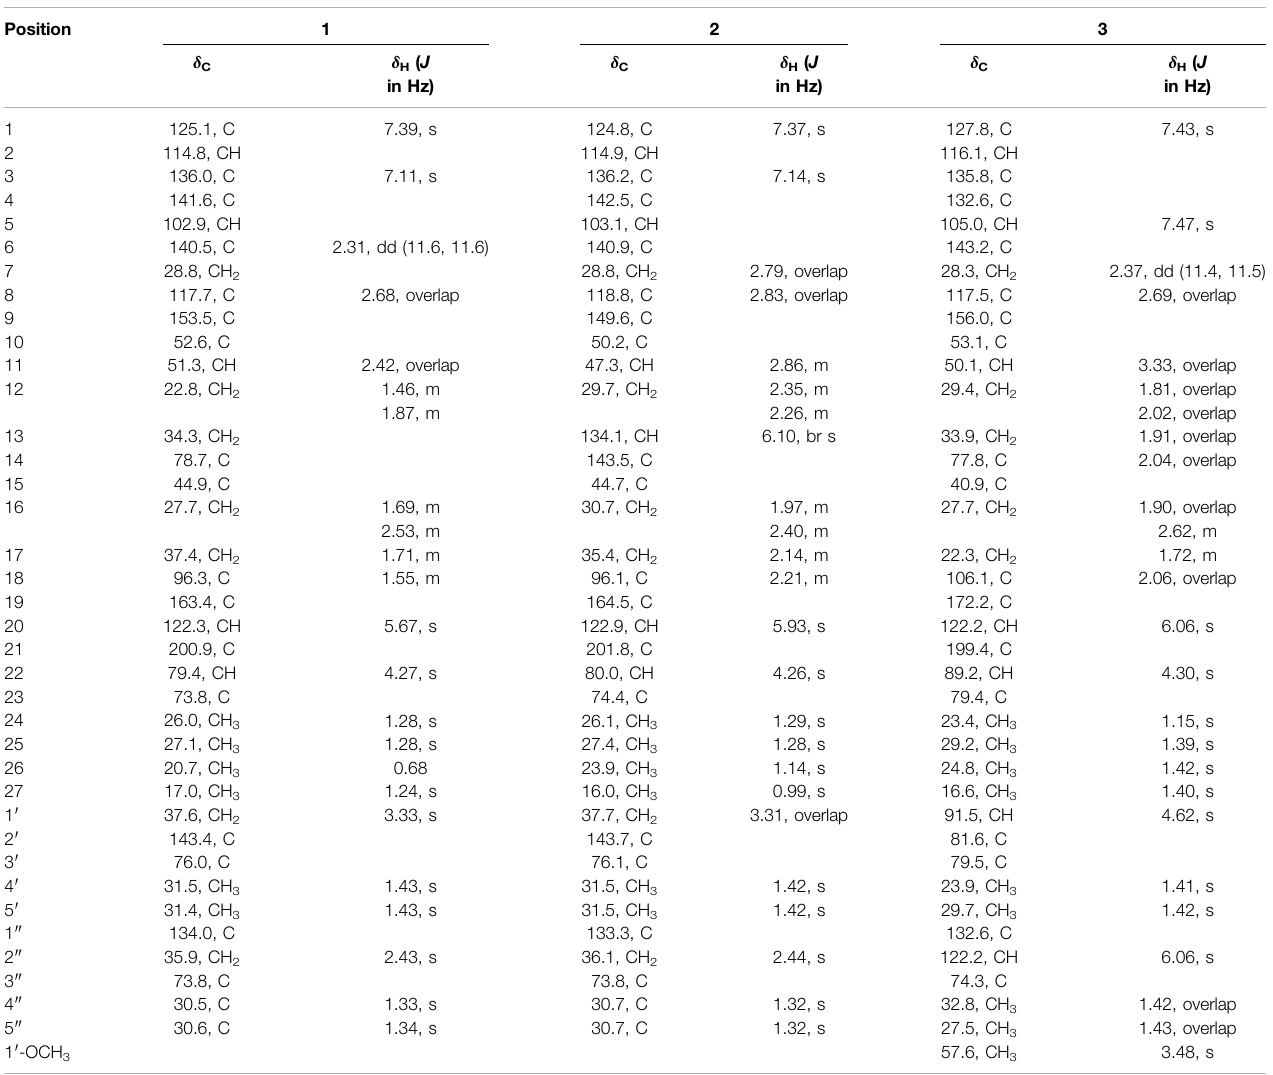
TABLE 1 | The 1 H (400 MHz) and 13 C NMR (100 MHz) data of compounds 1 – 3 in CD 3 OD.